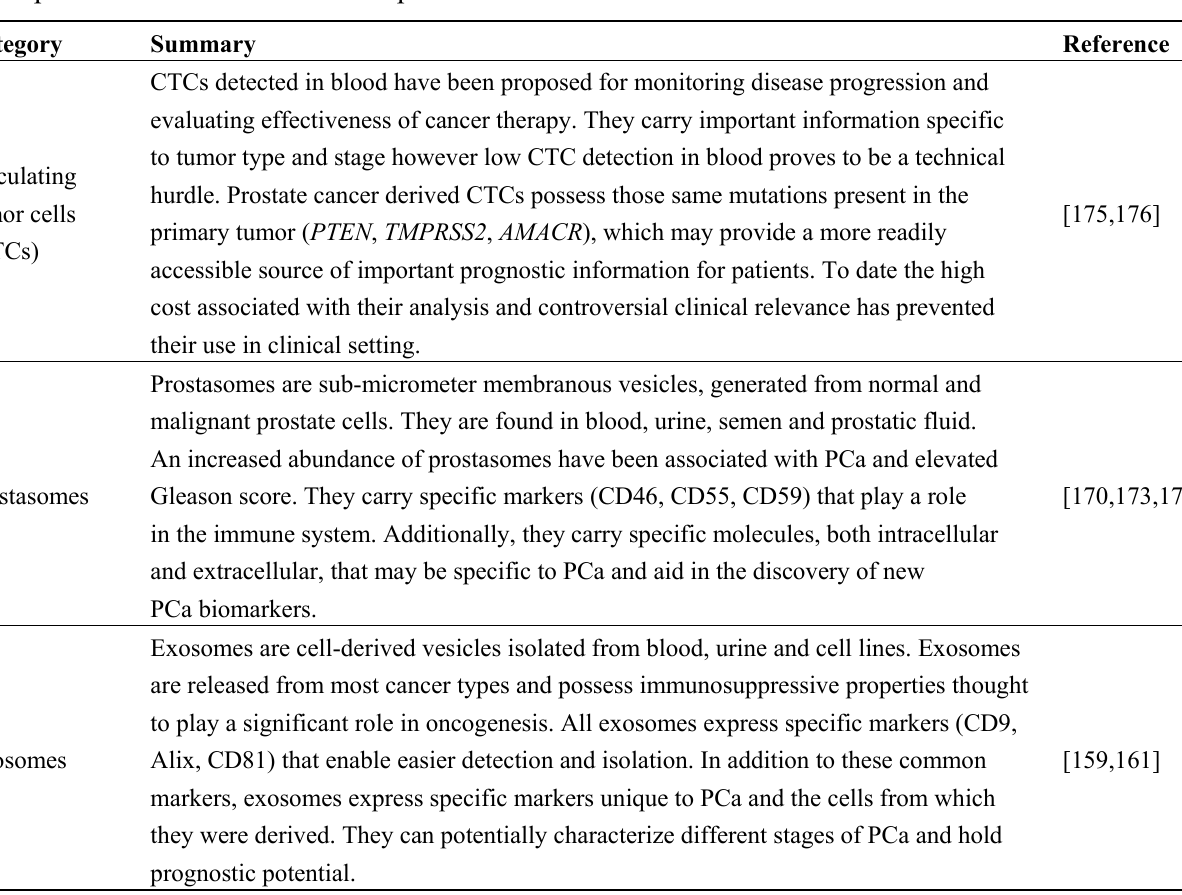
Table 3. Summary of diagnostic and prognostic potential of circulating tumor cells (CTCs) prostasomes and exosomes in prostate